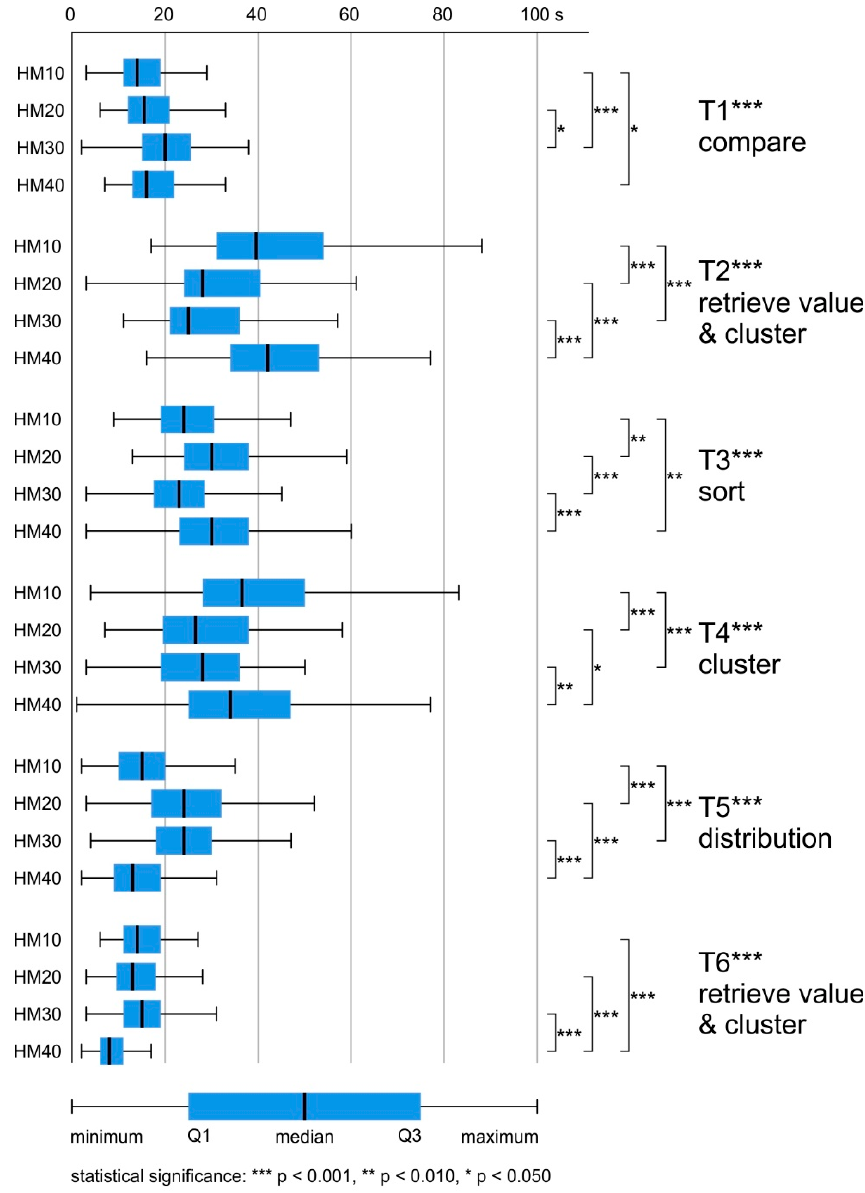
Figure 5. Differences in answer time between participants using the four tested heat maps.